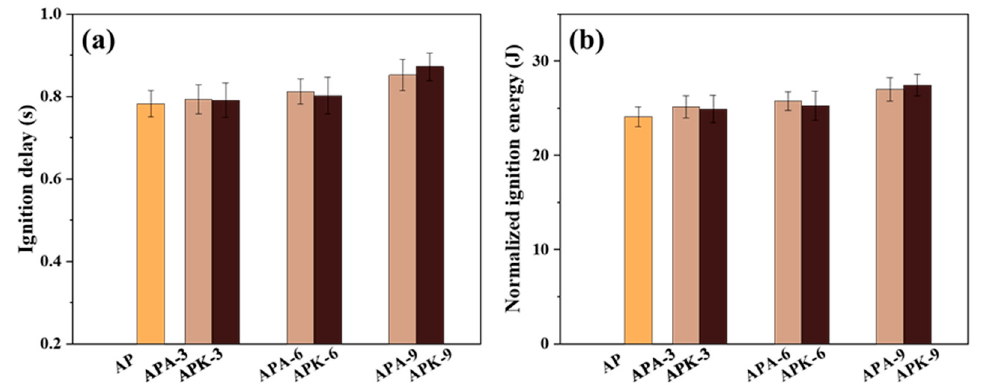
Figure 9. Ignition delay ( a ) and normalized ignition energy ( b ) for each sample.